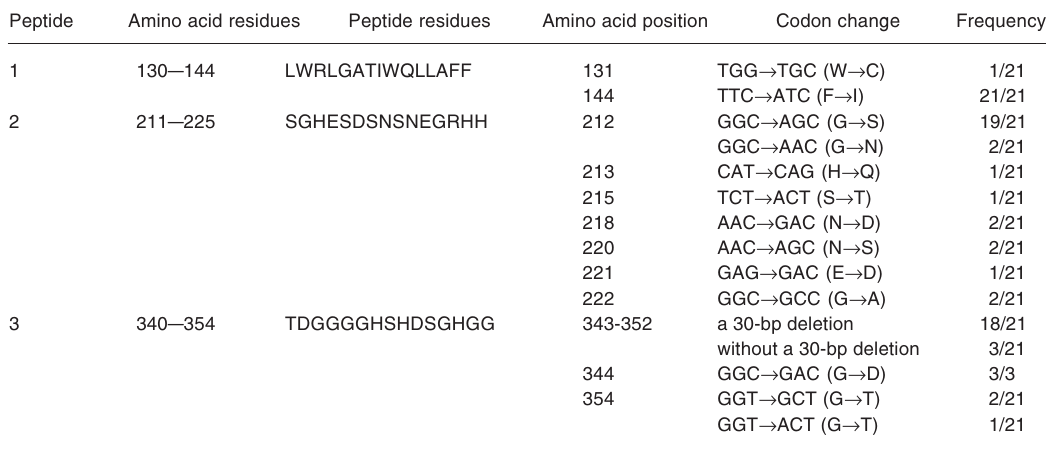
Table 1. Sequence variation in CD4+ T cell epitopes of latent membrane protein 1 (LMP1) from patients with nasopharyngeal carcinoma.